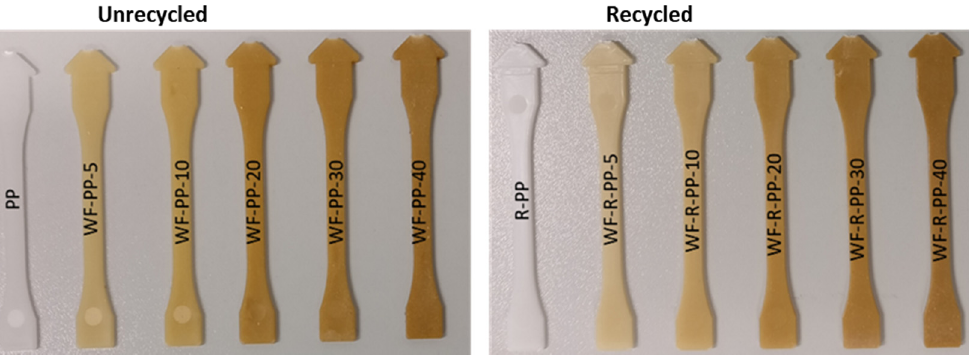
Figure 1. Samples composites with different wt. % of WF for unrecycled and recycled PP composite materials. As specified, surface tests were made on the dumbbell shaped samples seen in Figure 2. All surface tests were made in an area closer to the injection gate, indicated with a dotted line in Figure 2.